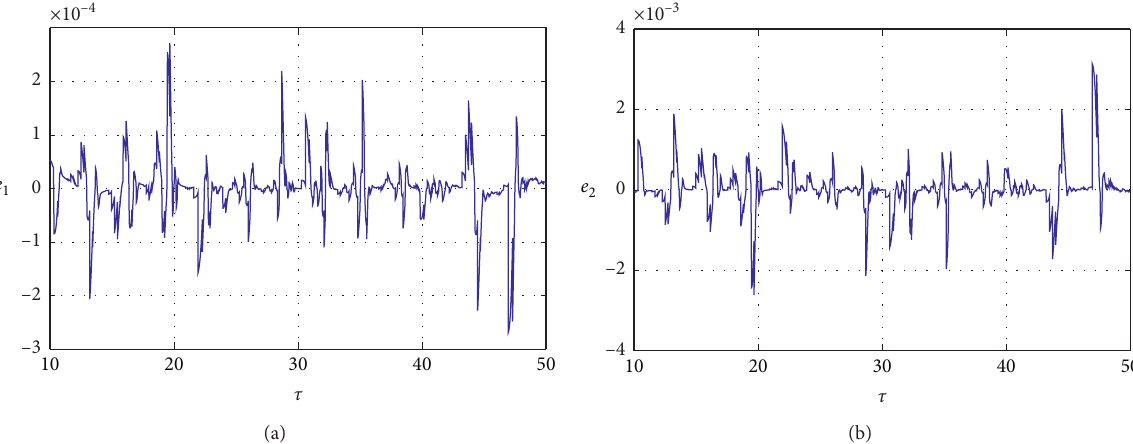
Figure 11: Deviation of the desired trajectory with the proposed control with parametric errors only in feedback control u by SDRE. (a) Deviation of the desired trajectory e 1 ; (b) deviation of the desired trajectory e 2 .